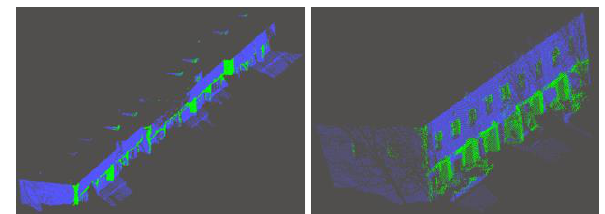
Figure 7. Close view of the false positive points (coloured in green) area on building facade.